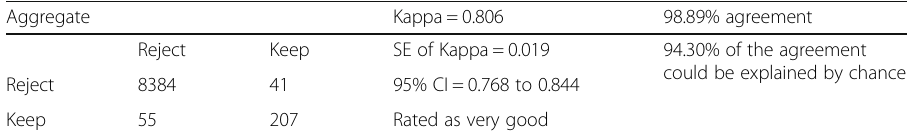
Table 1 Screening phase: review of titles and abstracts with relative agreement as indicated by Cohen ’ s